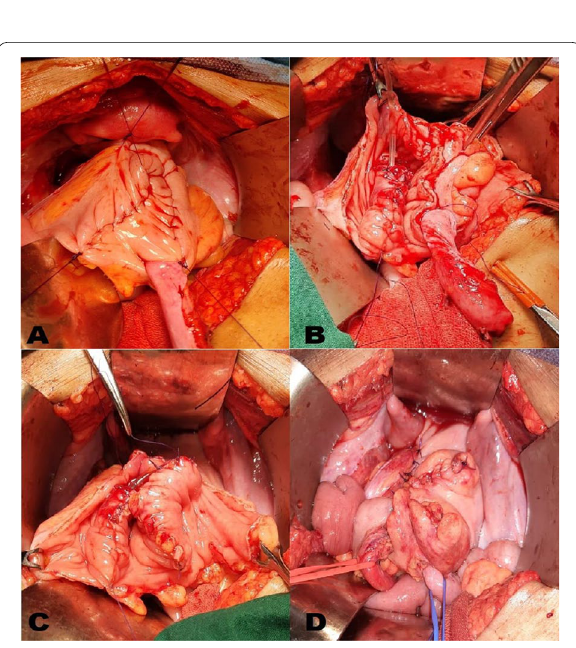
Fig. 2 A Bed for ureteral implantation, B Serosa lined extra-mucosal tunnelling, C Implanted ureters, D Rectosigmoid pouch